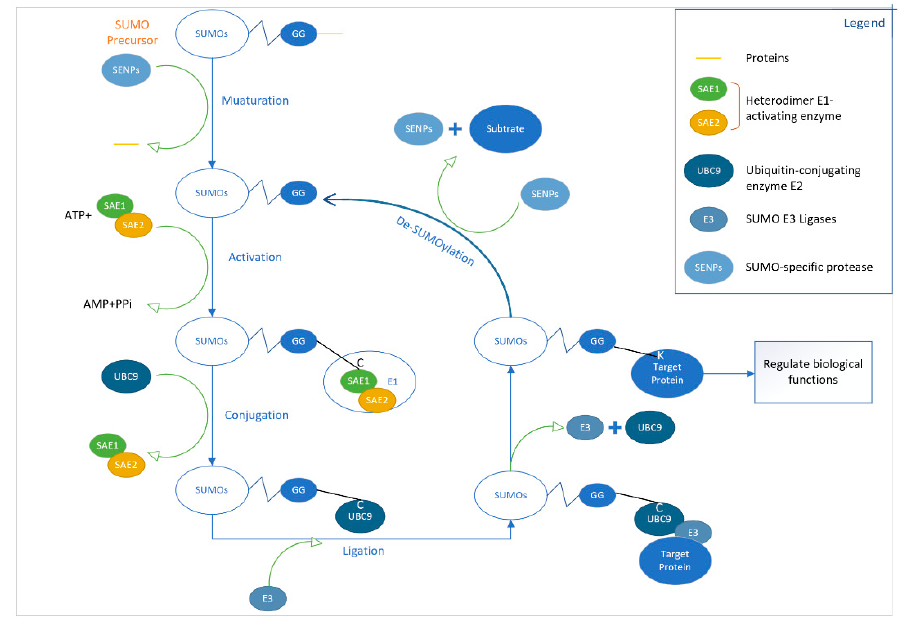
Figure 2. Schematic diagram showing the pathway related to protein SUMOylation. Maturation/de- SUMOylation: SENPs cleave the SUMOs protein from the precursor protein to produce mature SUMO protein; Activation: A thioester bond is formed between the GG of the SUMO protein and the cysteine residue of SAE1/2; Conjugation: A thioester bond is formed between the GG of SUMO protein and the cysteine residue of Ubc9; Ligation: Ubc9 and E3 ligases catalyse GG and target substrate lysine residues to form isopeptide bonds.